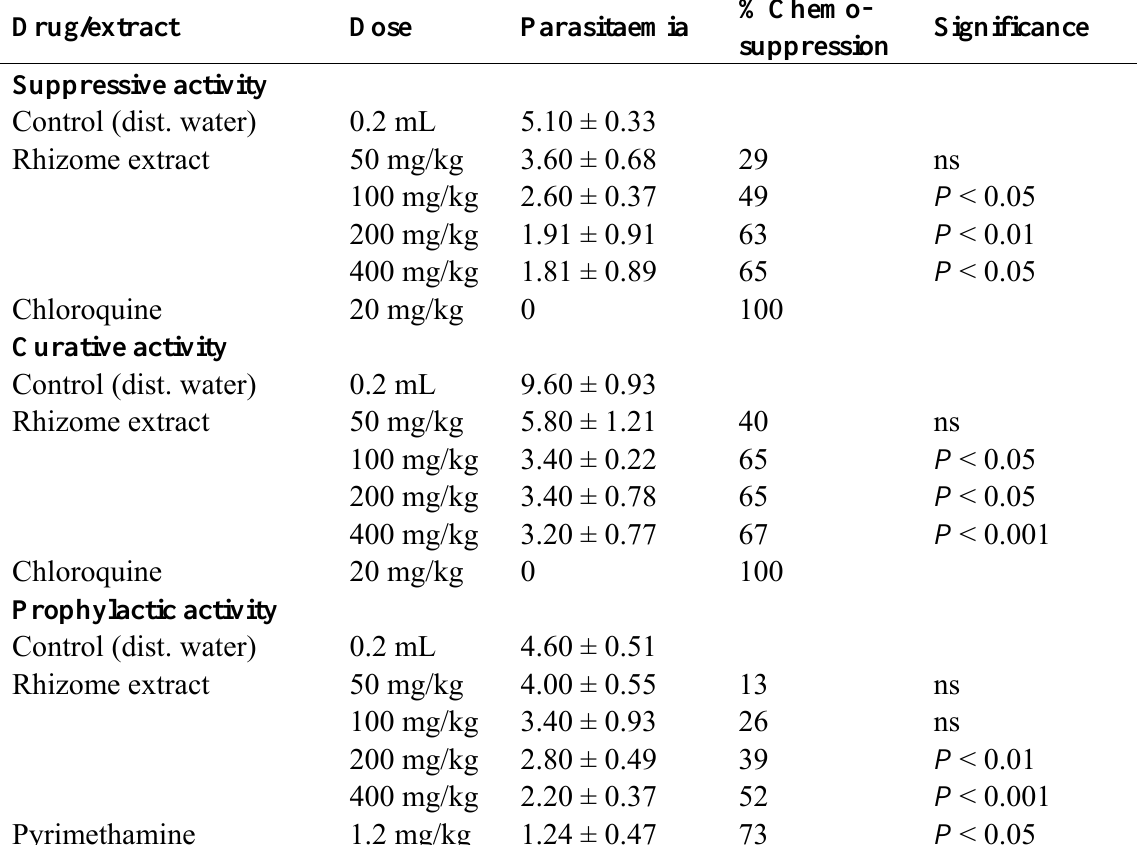
Table 2. The antimalarial activities of the methanolic extract of Languas galanga rhizomes during early, established and residual malaria